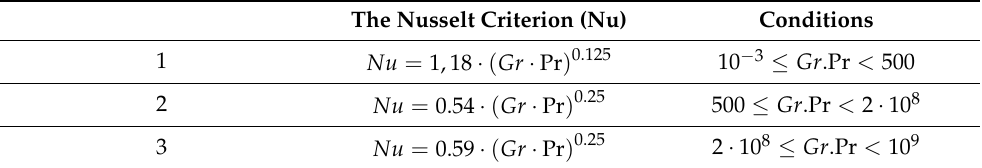
The Grashof criterion was defined